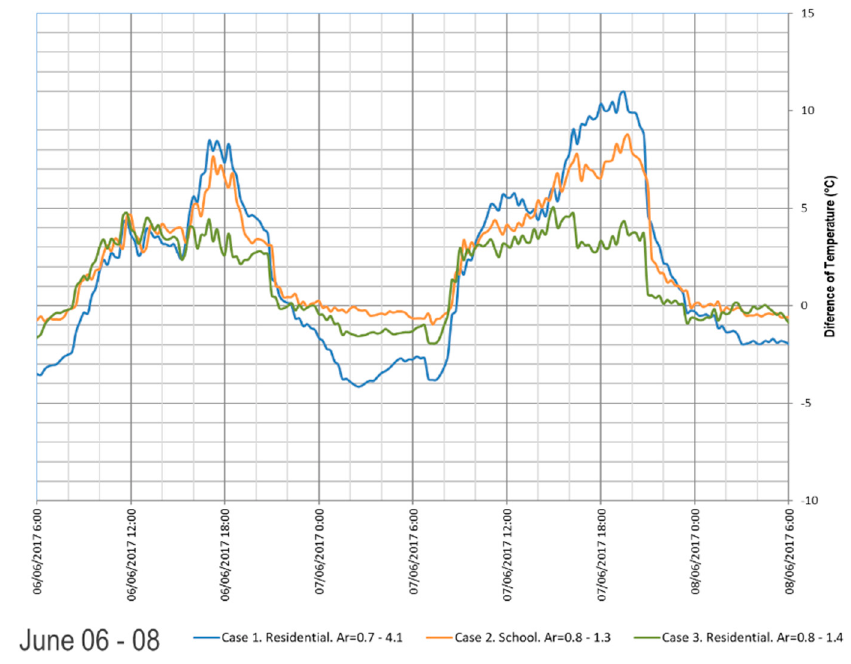
Figure 3. Outdoor-Courtyard Temperature Difference from 6th to 8th